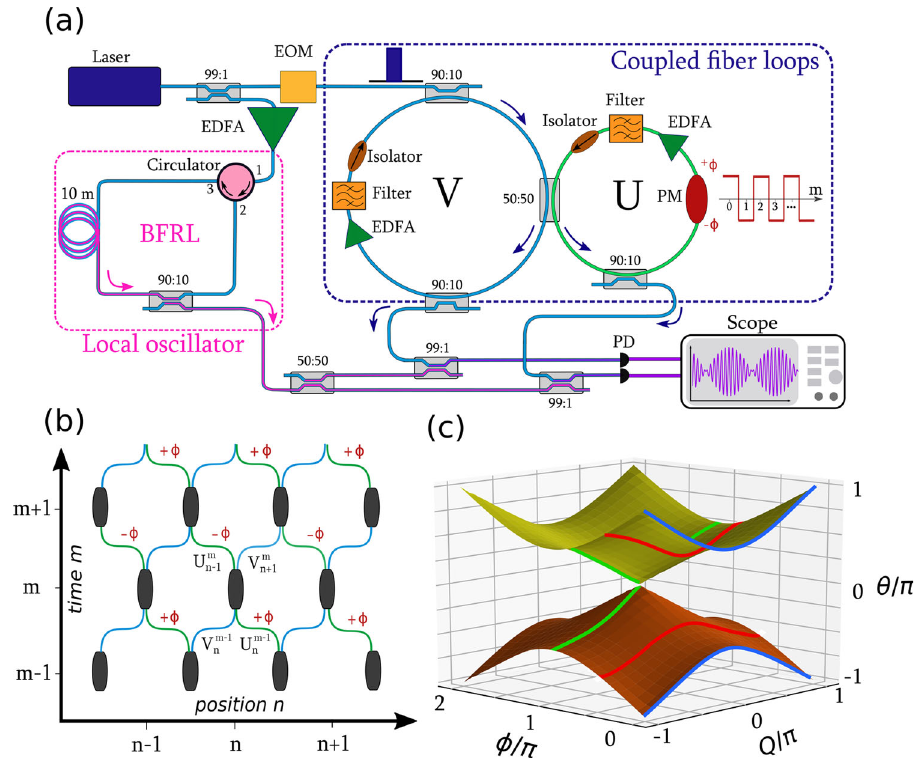
Fig. 1 Experimental fi ber loop system and associated Floquet – Bloch lattice. a Experimental setup showing the system of two coupled loops made with polarization-maintaining fi bers (PMFs) having lengths L 1 = 30.27 m and L 2 = 30.72 m. The local oscillator used for the heterodyne measurement is a Brillouin fi ber ring laser (BFRL) that is frequency detuned by ~10.8 GHz from the frequency of the signal circulating inside the loops. An electro-optic modulator is used to shape the pulses injected into the V loop. The losses in each loop are partially compensated by using Erbium-doped fi ber ampli fi ers (EDFAs). A phase modulator (PM) can be used for a periodic modulation of the phase between − ϕ and + ϕ in the U loop. Light detection at the output of the fi ber system is made using fast photodiodes (PDs). b Schematic representation of the Floquet – Bloch lattice on which the evolution of the light pulses circulating inside the loops can be mapped. The index n provides the position of the light pulses at the m th round trip in the Floquet – Bloch lattice. c Photonic band structure (Bloch momentum Q versus quasi-energy θ ) for different values of the phase modulation ϕ within the U loop.